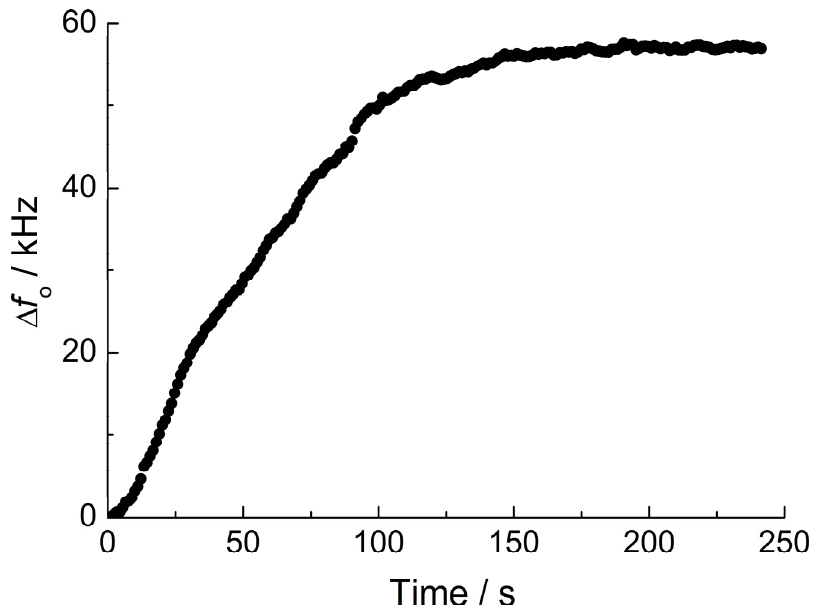
Figure 4. Typical curve of oscillation frequency difference ( Δ f 0 = f water ( t )— f water (0)) of the QCM sensors coated by SPNBI-I,III immersed in water ( f water ( t )) relative to the value of its oscillation frequency at the moment of its immersion in water ( f water (0)) as a function of time.